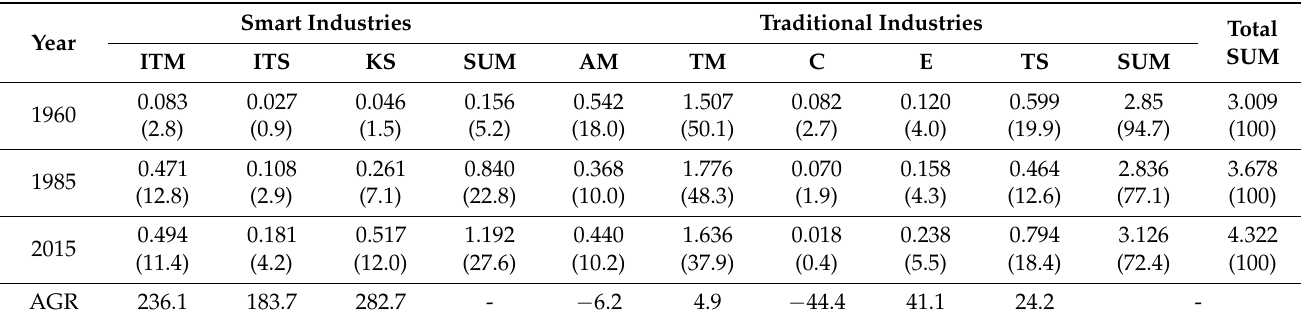
Table 2. Changes in smart penetration (unit: coefficient,